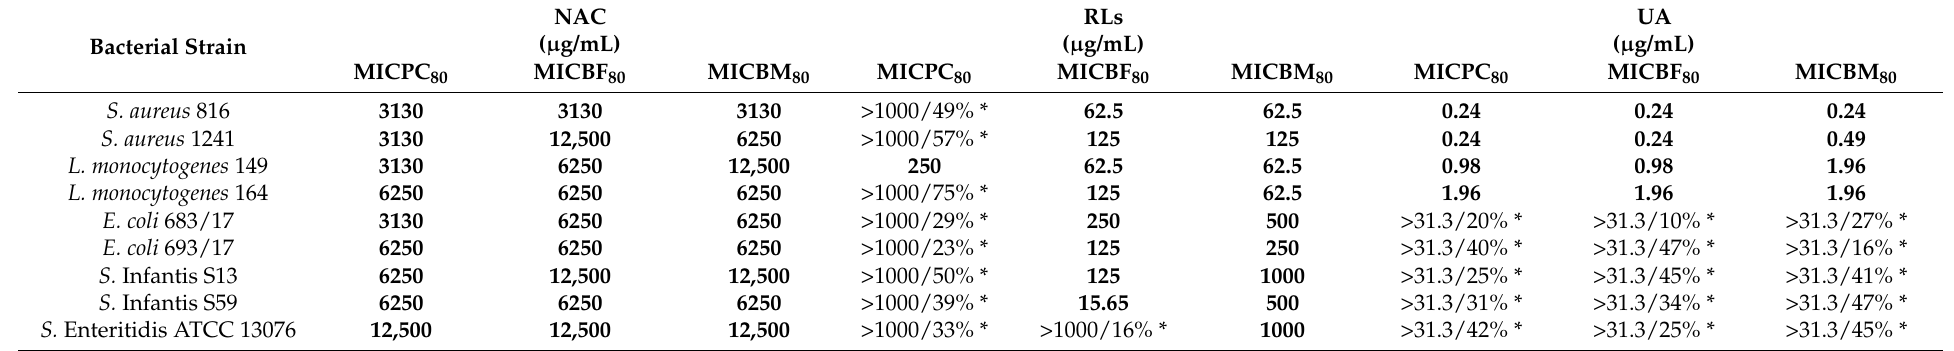
Table 1. Minimal inhibitory concentrations of N -Acetyl- L -cysteine (NAC), rhamnolipids (RLs), and usnic acid (UA) for planktonic growth, biofilm formation, and the resulting biofilm metabolic activity. The significance of the results was verified by t -test ( p = 0.05). NAC Bacterial Strain